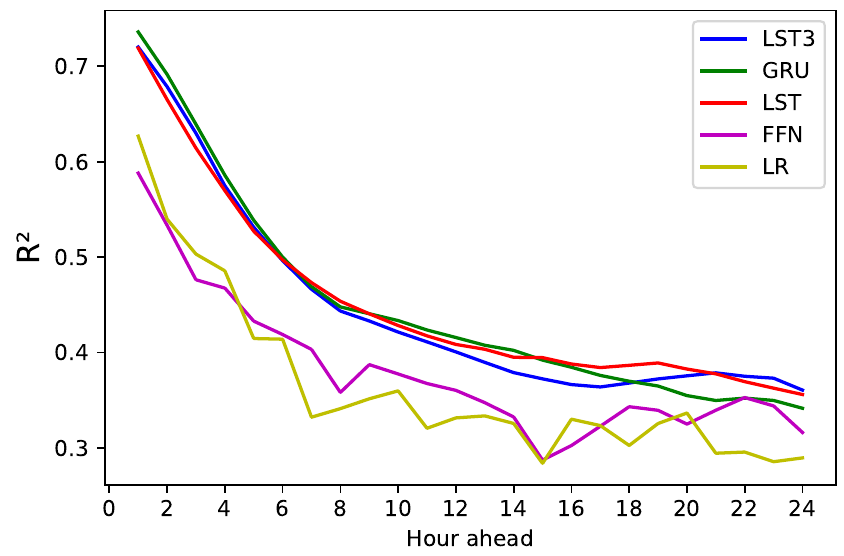
Figure 7. Behavior of R 2 for the PM 2.5 24 h forecasts at Cerro Navia station during 2013 for each hour of the day using different methods.